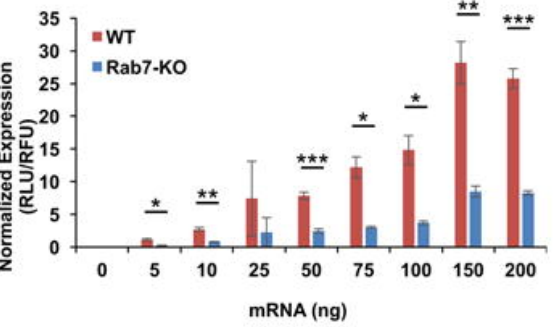
Figure 5. Late endosomes are essential for mRNA transfection wild-type (WT) and HAP1 cells with deleted Rab7 (Rab7-KO) were transfected with luciferase mRNA lipoplexes. A clear decrease in luciferase expression in Rab7-KO cells was evidenced. Adapted with permission from [88]. Copyright (2021) American Chemical Society. (* 0.05 ≥ p > 0.01, ** 0.01 ≥ p > 0.005, *** 0.005 ≥ p )